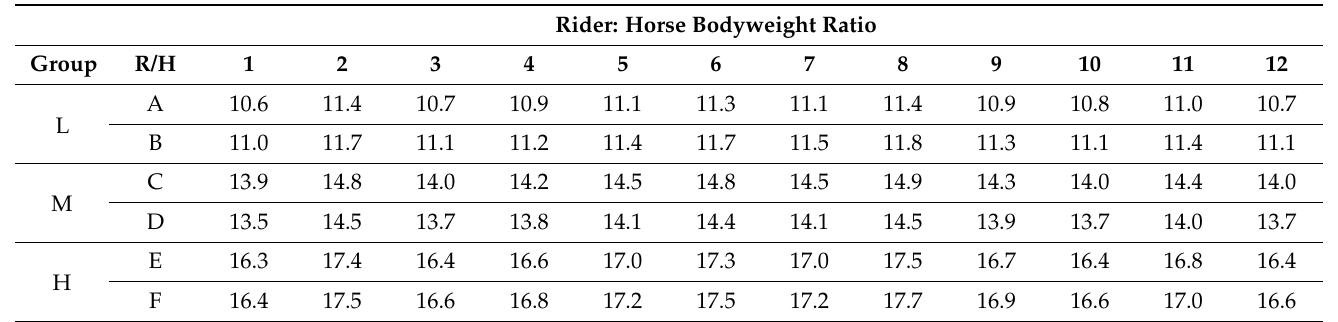
Table 2. The rider:horse bodyweight ratio calculated for combinations (R/H) of six riders (A–F), representing light (L), moderate (M), and heavy (H) groups, and twelve horses (1–12). Rider: Horse Bodyweight